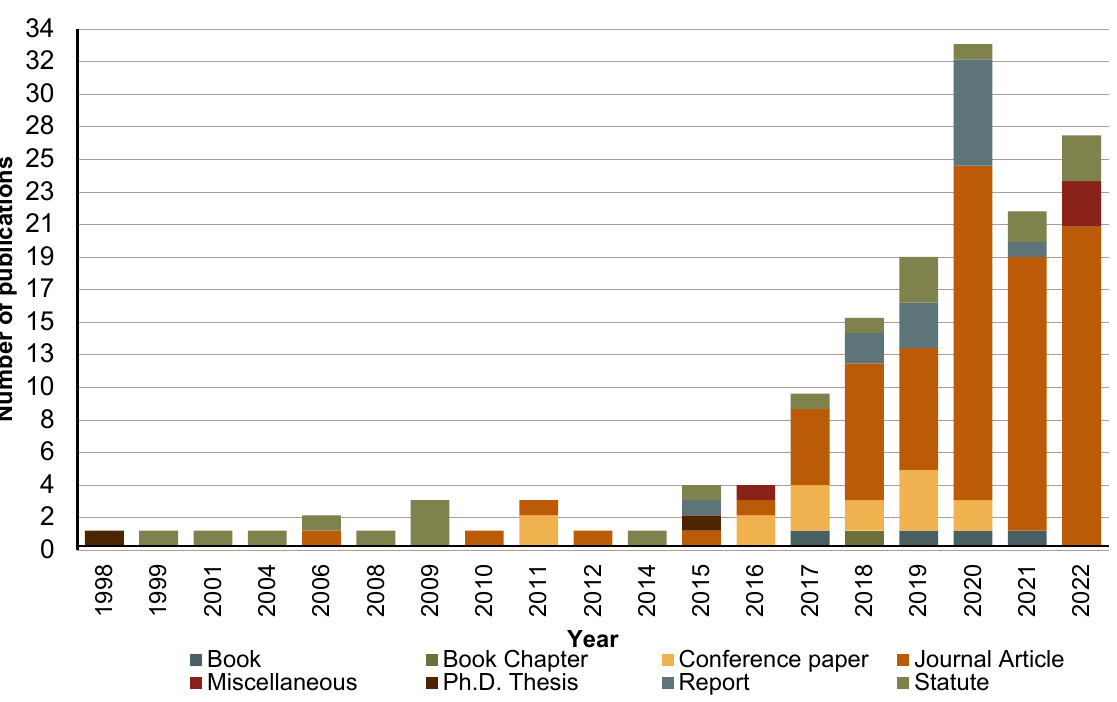
Figure 2. Reviewed literature by publication type.